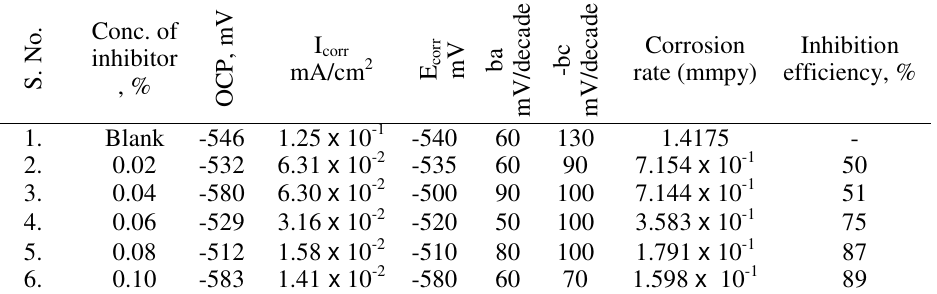
Table 4. Potentiostatic polarization studies for mild steel corrosion in phosphoric acid with AV o N S .